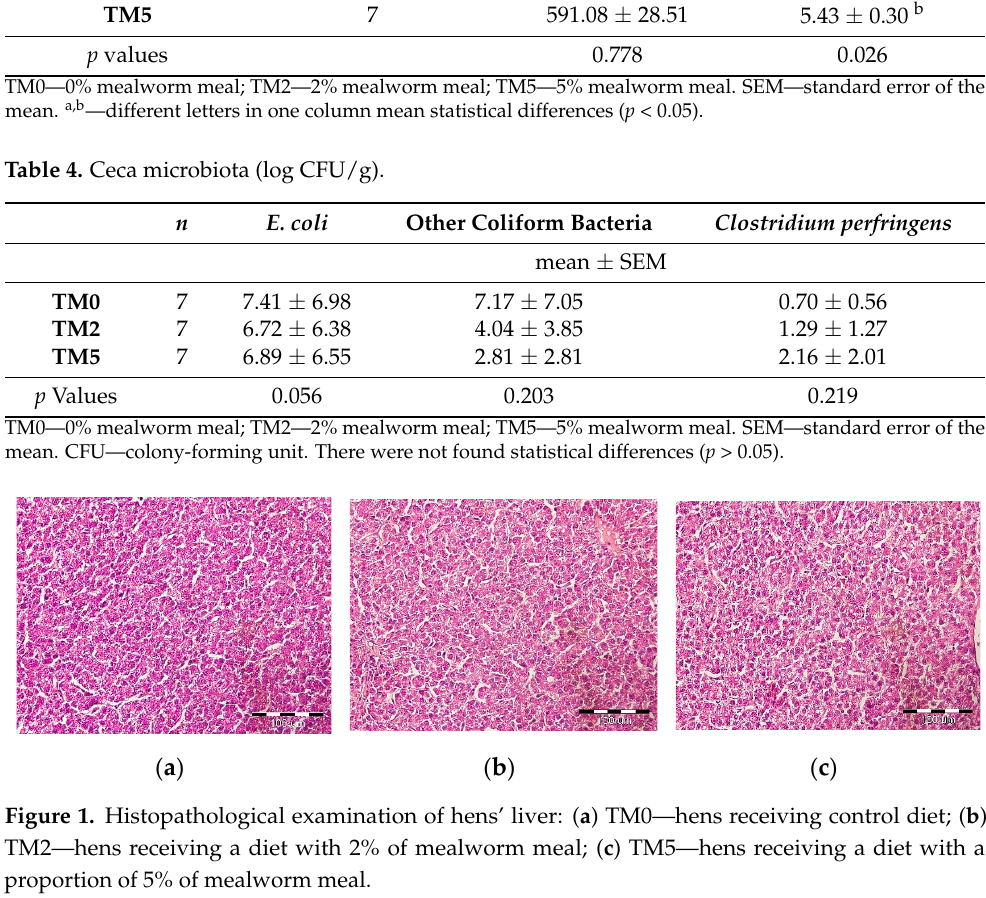
Table 3. Ileum villus height and ileum digesta viscosity.